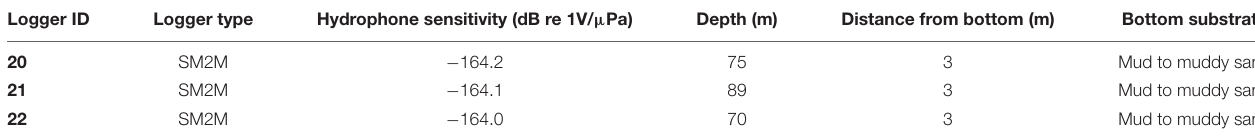
TABLE 1 | Information on hydrophone loggers and deployment details.